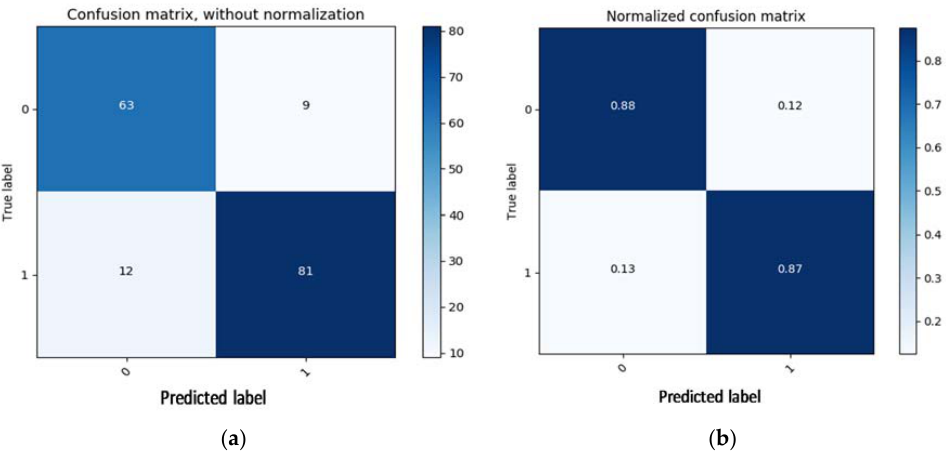
Figure 7. Confusion matrix (CM) with and without normalization of the MLP algorithm; ( a ) 63 arrhythmias and 81 normal signals are correctly classified, while 9 arrhythmias and 12 normal ECG signals are misclassified; ( b ) CM with normalization gives an accuracy in percentage; in this case, accuracy was 88% for arrythmia and 87% for normal sinus ECG.